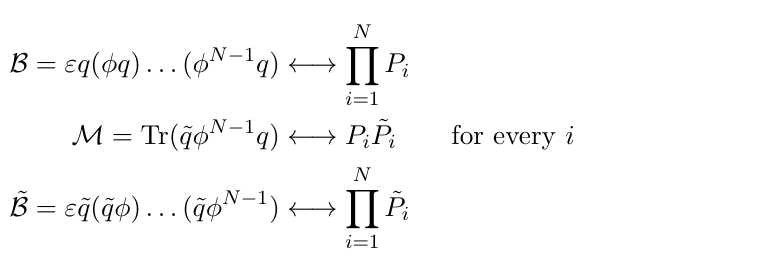
[ r (cid:30) ; 1 ; 0]. On the right Z SU(2) 2